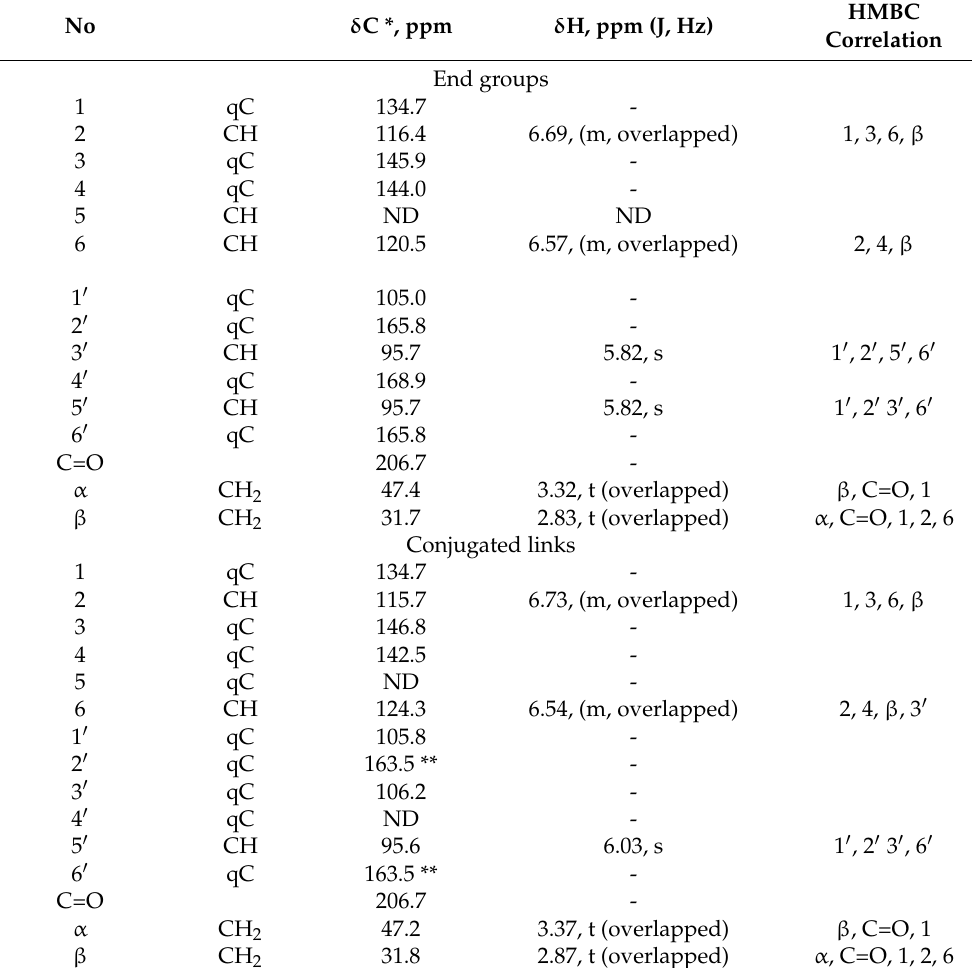
Table 2. NMR Spectroscopic data for 3-hydroxyphloretin oligomers in fractions